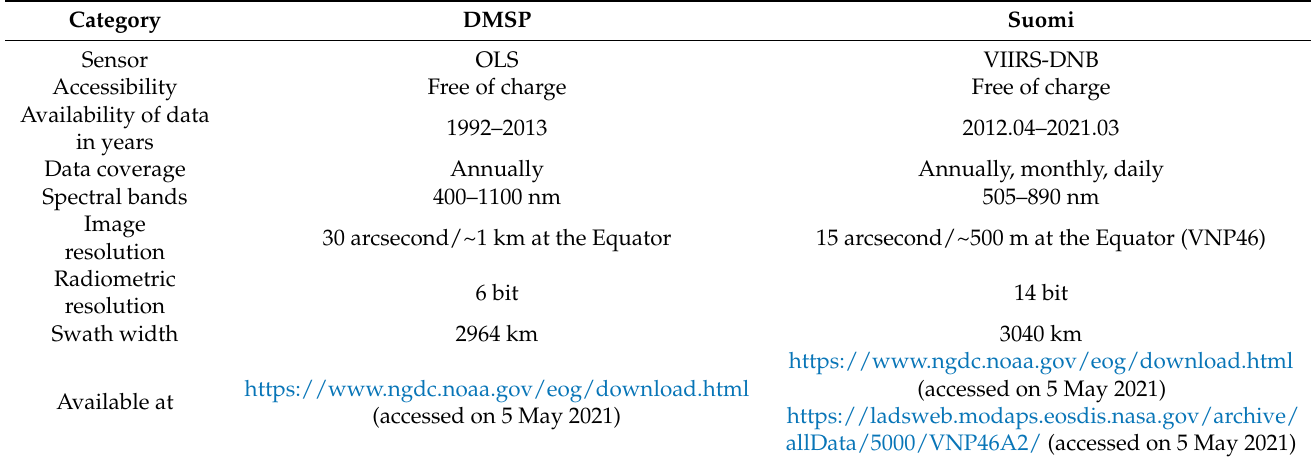
Table A3. The key differences between the DMSP-OLS and Suomi NPP-VIIRS satellites/sensors which both provide free-of-charge data based on [57,191,192]. Source: authors’ elaboration.